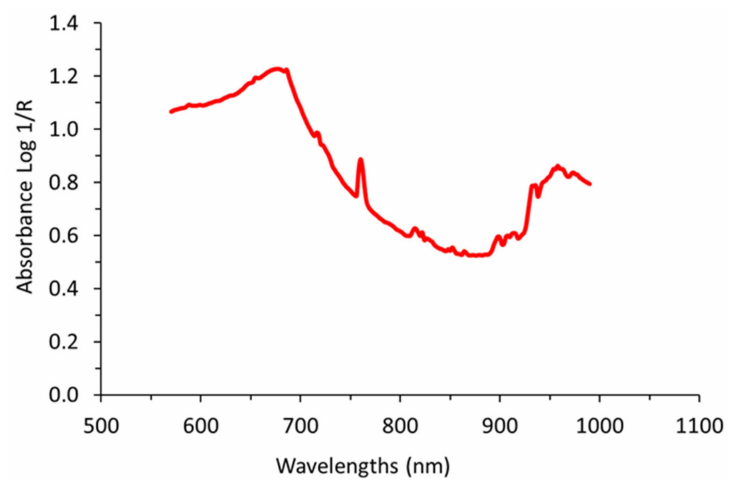
Figure 6. Spectral signature manually taken and averaged previous to on-the-go acquisitions from several grape clusters. This signature was used for filtering the on-the-go spectra and to select only those spectral signals belonging to grape clusters.